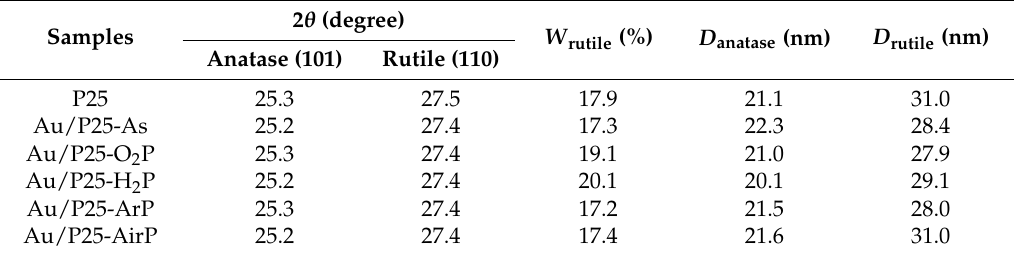
Figure 3. Typical transmission electron microscopy (TEM) images of ( a ) Au/P25-As; ( b ) Au/P25-O 2 P; ( c ) Au/P25-H 2 P; ( d ) Au/P25-ArP; ( e ) Au/P25-AirP, and the corresponding size distribution histograms of gold nanoparticles. Table 1. Structure properties of the Au/P25 catalysts as prepared and activated by AP cold plasma, as well as P25 support.